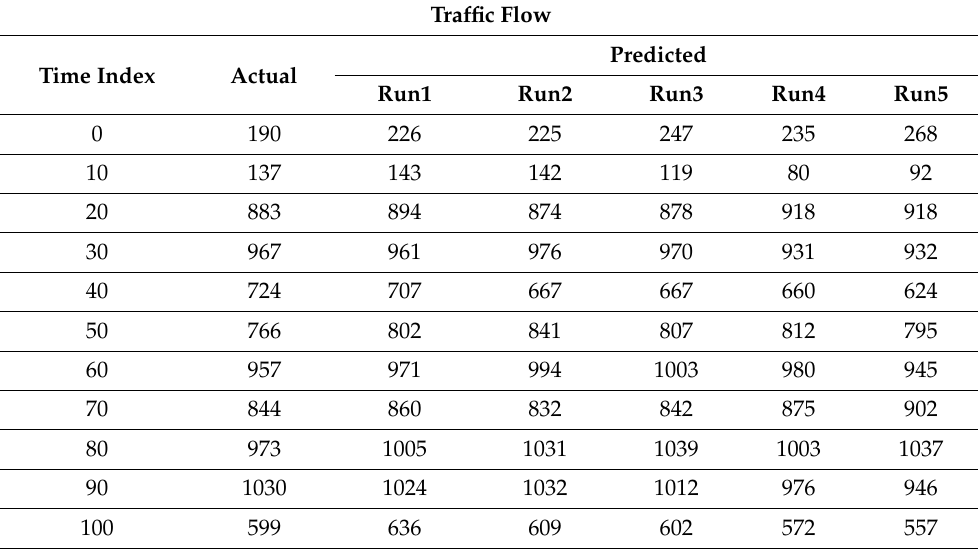
Table 2. Traffic flow analysis of AST2FP-OHDBN approach with distinct runs.